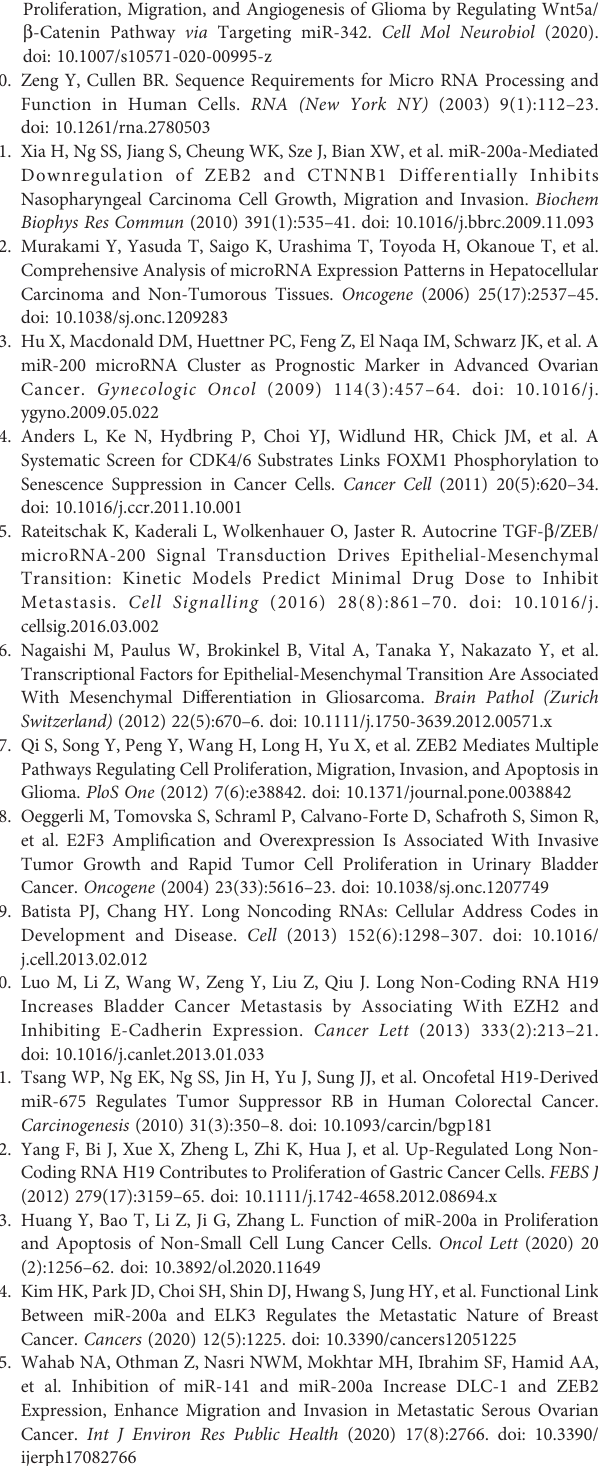
Supplementary Figure 1 | (A – D) The invasion and migration of transfected cells were determined using Transwell assays. Data were presented as mean ± SEM; * P < 0.05 vs control group. # P < 0.05 vs sh-H19 group. NC, negative control.